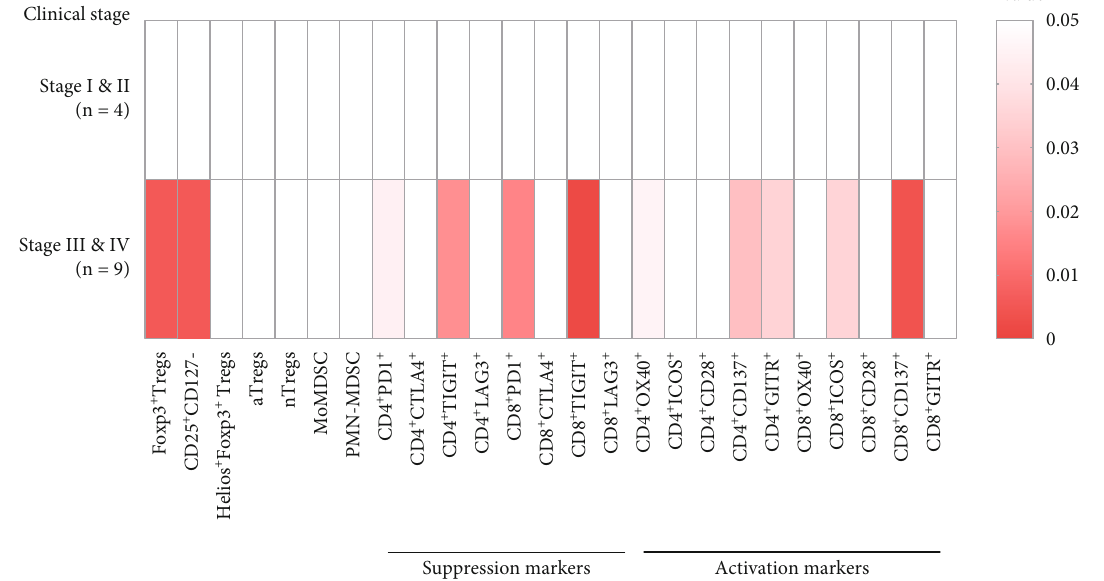
Figure 2: Immunological features of SN and NSN in patients at di ff erent clinical